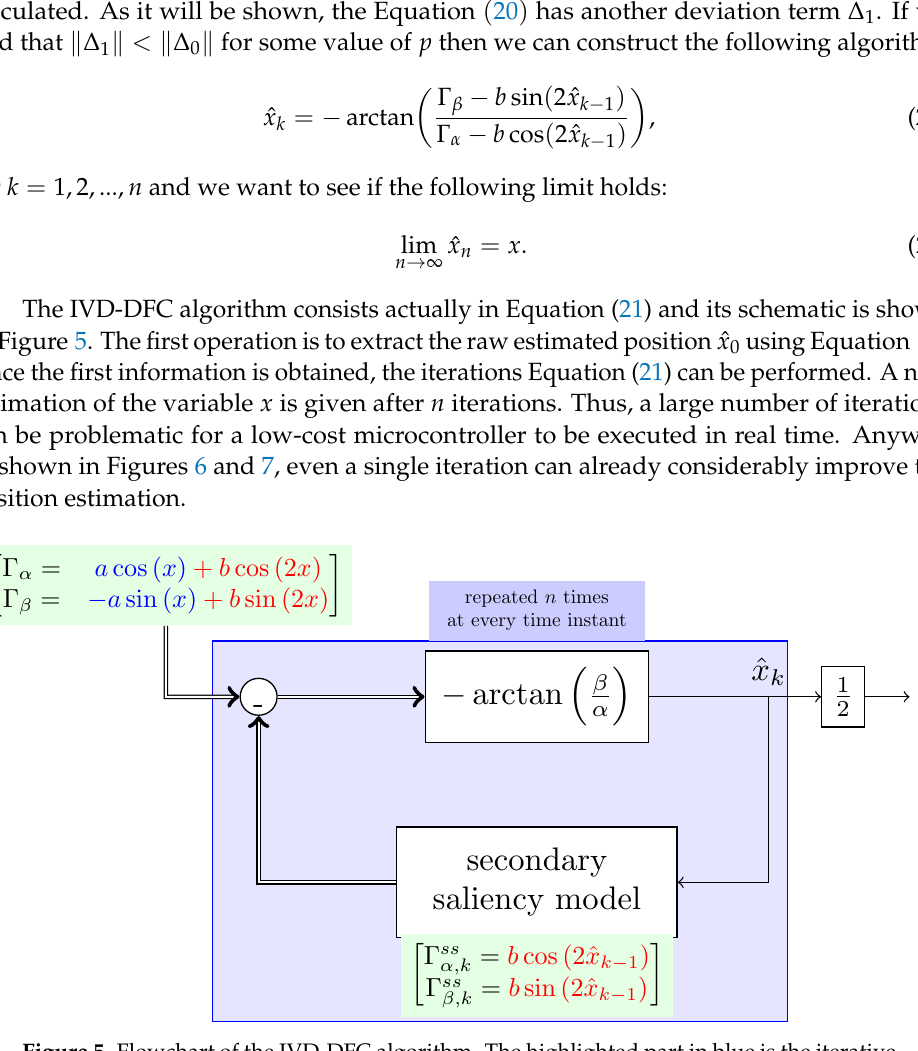
Figure 5. Flowchart of the IVD-DFC algorithm. The highlighted part in blue is the iterative is a zero vector for k = part. It is assumed that the vector Γ ss α , β